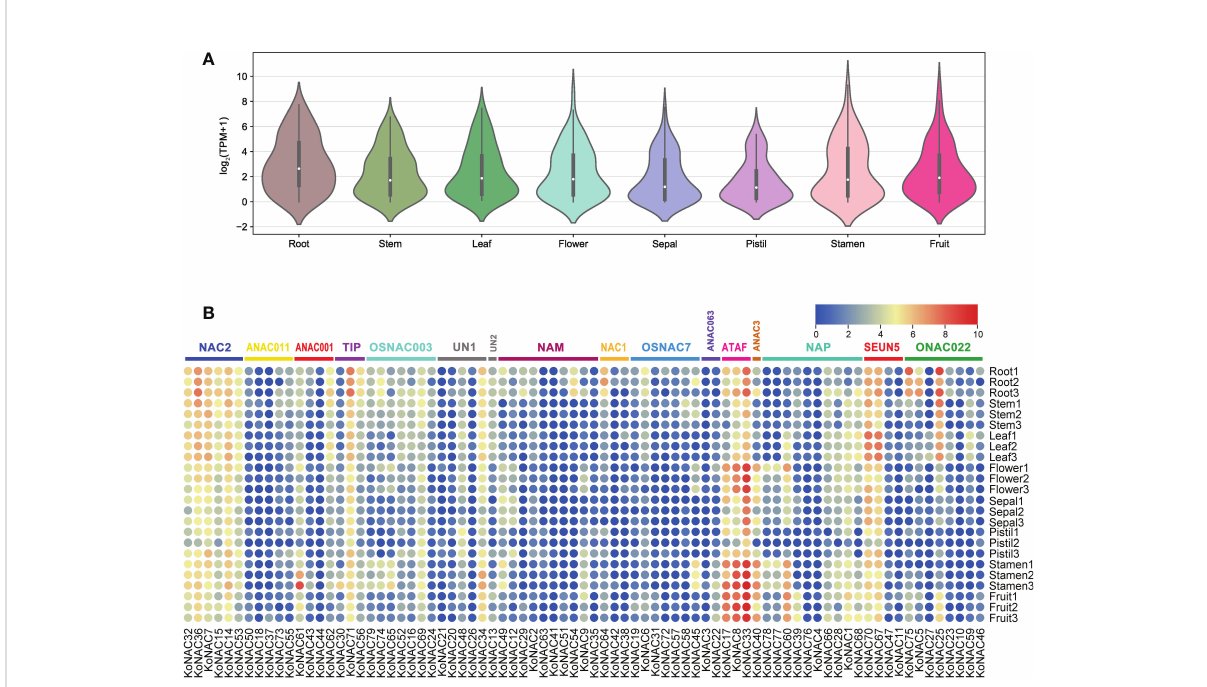
FIGURE 8 Expression of KoNAC genes in Kandelia obovata . (A) Bean plot of the expression levels of all KoNACs in different tissues. (B) The transcript levels of the KoNAC genes in 8 tissues of K. obovata were investigated based on publicly available transcriptomic data. The color scale shows increasing expression levels from blue to